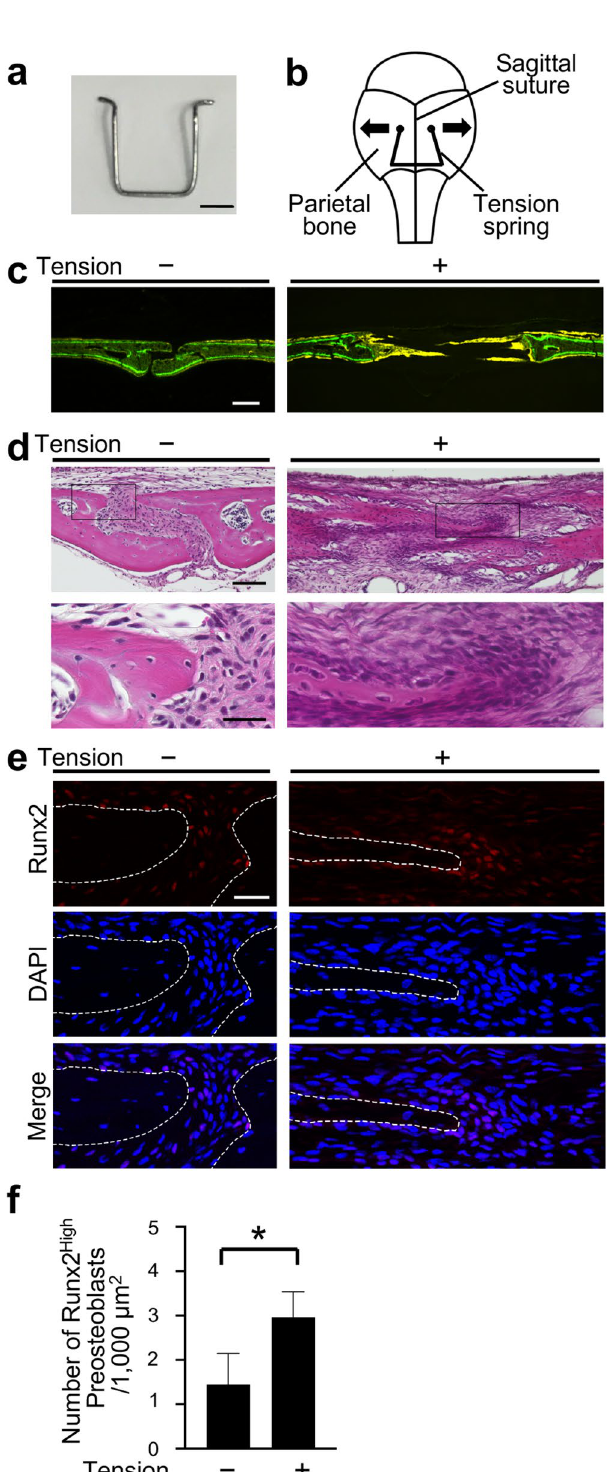
Figure 1. Preosteoblasts were aggregated at the osteogenic front of calvarial bones in the mouse tensile force-induced bone formation model. ( a ) A spring for tensile force loading. Scale bar = 2 mm. ( b ) A schematic diagram of a tension spring placed on the mouse parietal bones. To apply 0.2 N of tensile force to the sagittal suture, a tension spring was set within holes drilled in the right and left parietal bones of 6-week-old mice. Arrows indicate the direction of tension force on the parietal bones. The schematic diagram was created using Affinity Designer (version 1.8.6; https ://affin ity.serif .com/en-us/desig ner/). ( c ) Fluorescence micrographs show bone labels with tetracycline (yellow) and calcein (green) in the parietal bones. Scale bar 200 μm. ( d ) The parietal bone and sagittal suture at 7 days after application of tensile force were stained with hematoxylin and eosin. Lower panels show the magnified images of rectangles in upper panels. Scale bar = 100 µm in upper panels, and 30 µm in lower panels. ( e , f ) The expression of Runx2 was analyzed by immunohistochemistry ( e ), and the number of Runx2 High preosteoblasts at the osteogenic front ( f ) was evaluated (6 animals per group). The dotted line in the image of immunohistochemistry indicates the border of mineralized bone. Scale bar = 30 μm. *p < 0.05, Student’s